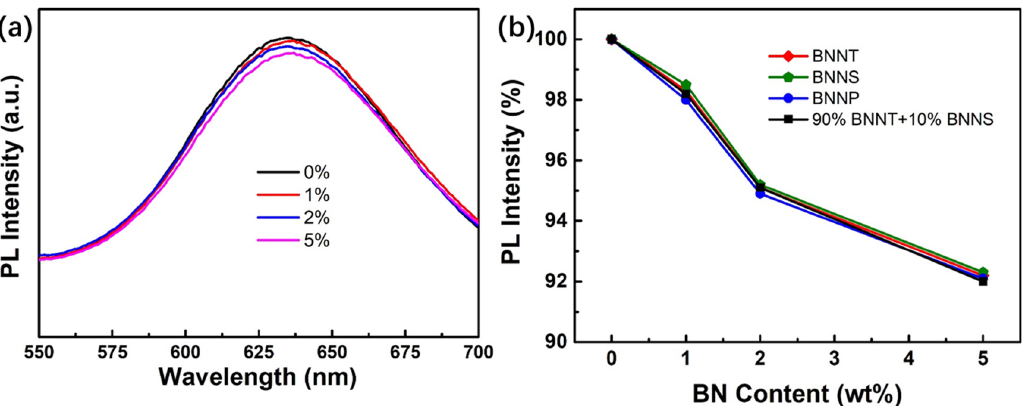
Figure 11. ( a ) Emission spectra of PiG with di ff erent content of BNNT; ( b )PL intensity of PiG with di ff ernent BN nanomaterial.